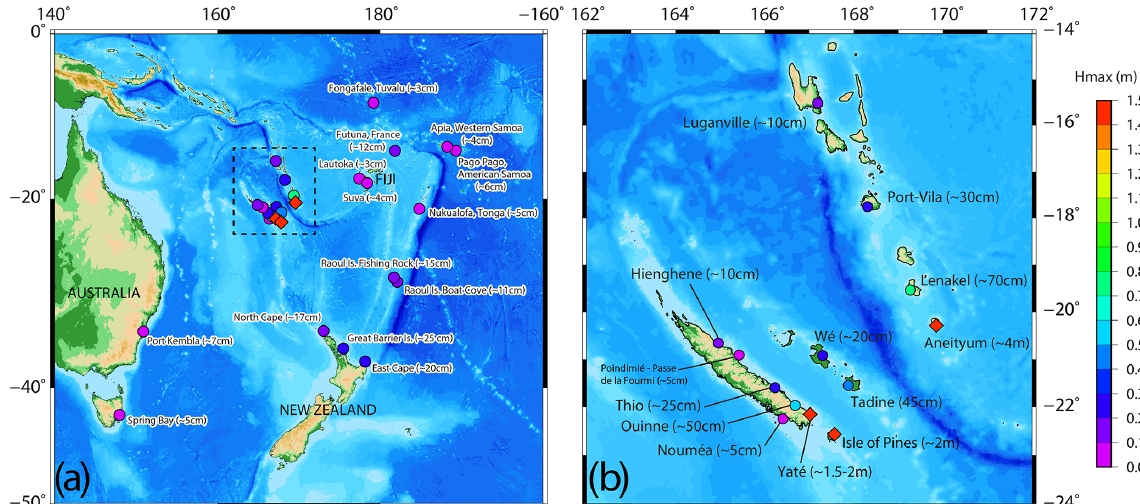
Figure 3. Tsunami maximum wave amplitude of the 5 December 2018 tsunami in the southwestern Pacific region. Monitored amplitudes are represented with colored circles, while those coming from witness observations are represented by